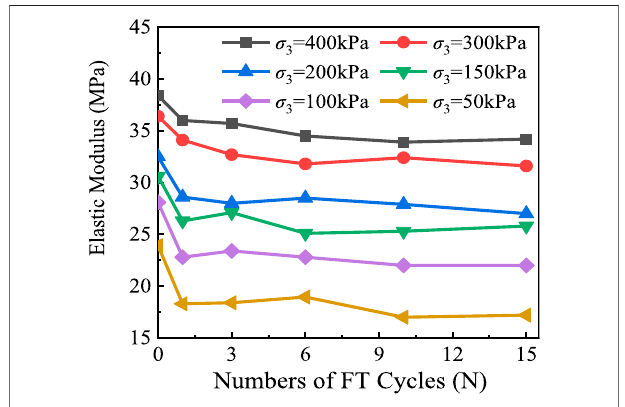
FIGURE 5 | Failure strength under various con fi ning pressures and FT